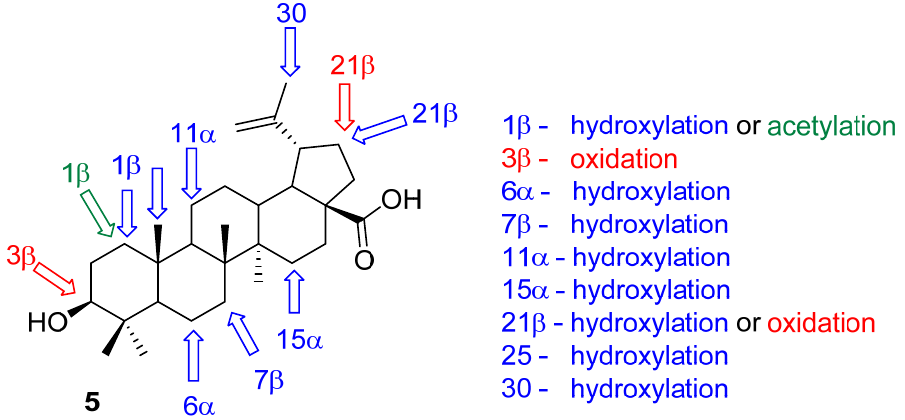
Figure 5. Positions of the Betulinic acid ( 5 ) which are most commonly modified by microbial oxidations using various fungal and bacterial species.